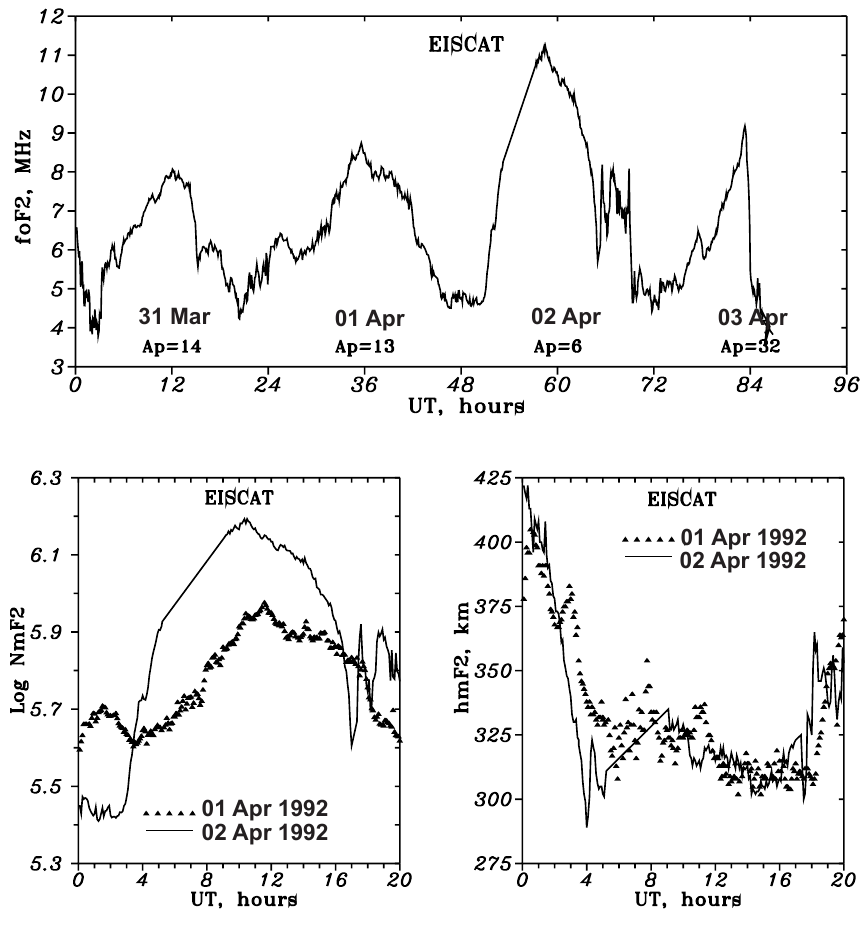
Fig. 9. Daily fo F2 variation for suc- cessive days during a vernal transition period at EISCAT (top panel). Daily Ap indices are also given. Bottom pan- els show diurnal NmF2 and hm F2 vari- ations for a winter-like (02 Apr 1992) and summer-like (01 Apr 1992) day analyzed for thermospheric parameter variations (LT = UT − 1 .